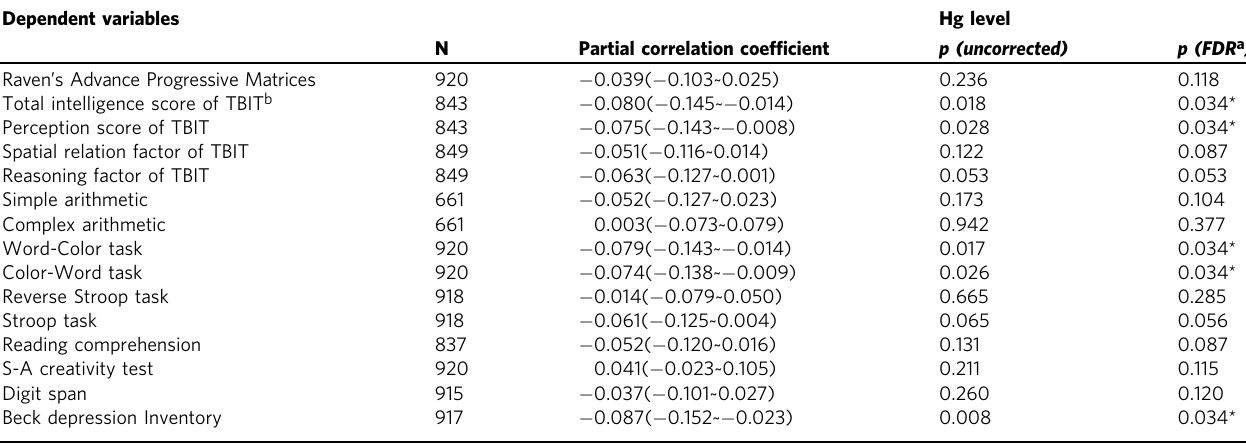
Table 1 Results of partial correlation analyses performed using psychological variables and hair mercury level after correcting for confounding